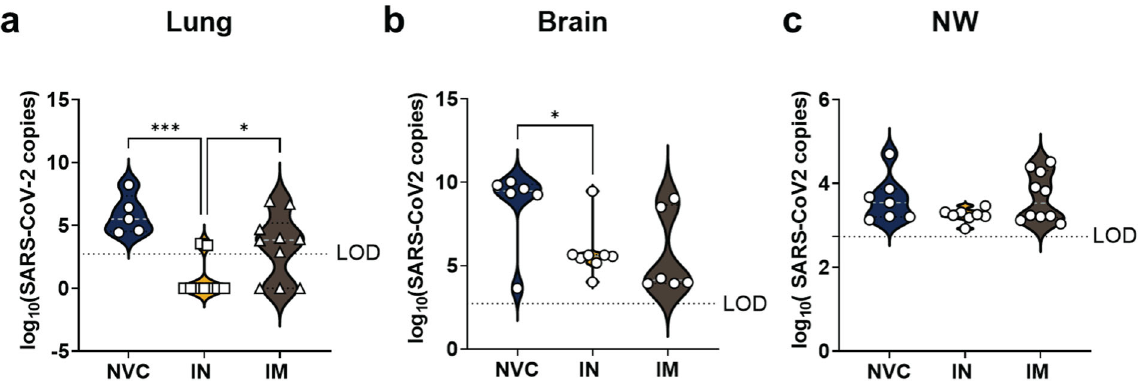
Fig. 4 Determination of viral RNA levels in challenged mice. 100 ng of lung and brain homogenate was used to perform qPCR analysis on the SARS-CoV-2 nucleocapsid RNA. a Violin plots depicting the SARS-CoV-2 viral RNA copies in the right lobe of the lung, with white dotted line representing the median for each group plot. Ordinary one-way ANOVA with Sidak ’ s multiple comparisons test was used to perform statistical analysis. P = 0.0007***, and P = 0.0436*. b Violin plots depicting the SARS-CoV-2 viral RNA copies in the left lobe of the brain, with white dotted line representing the median for each group plot. Unpaired T-test was performed for statistical analysis. P = 0.0230*. c 500 µL of nasal wash (NW) was assessed for qPCR quanti fi cation of viral nucleocapsid RNA. Violin plots representing the SARS-CoV-2 viral RNA copies.